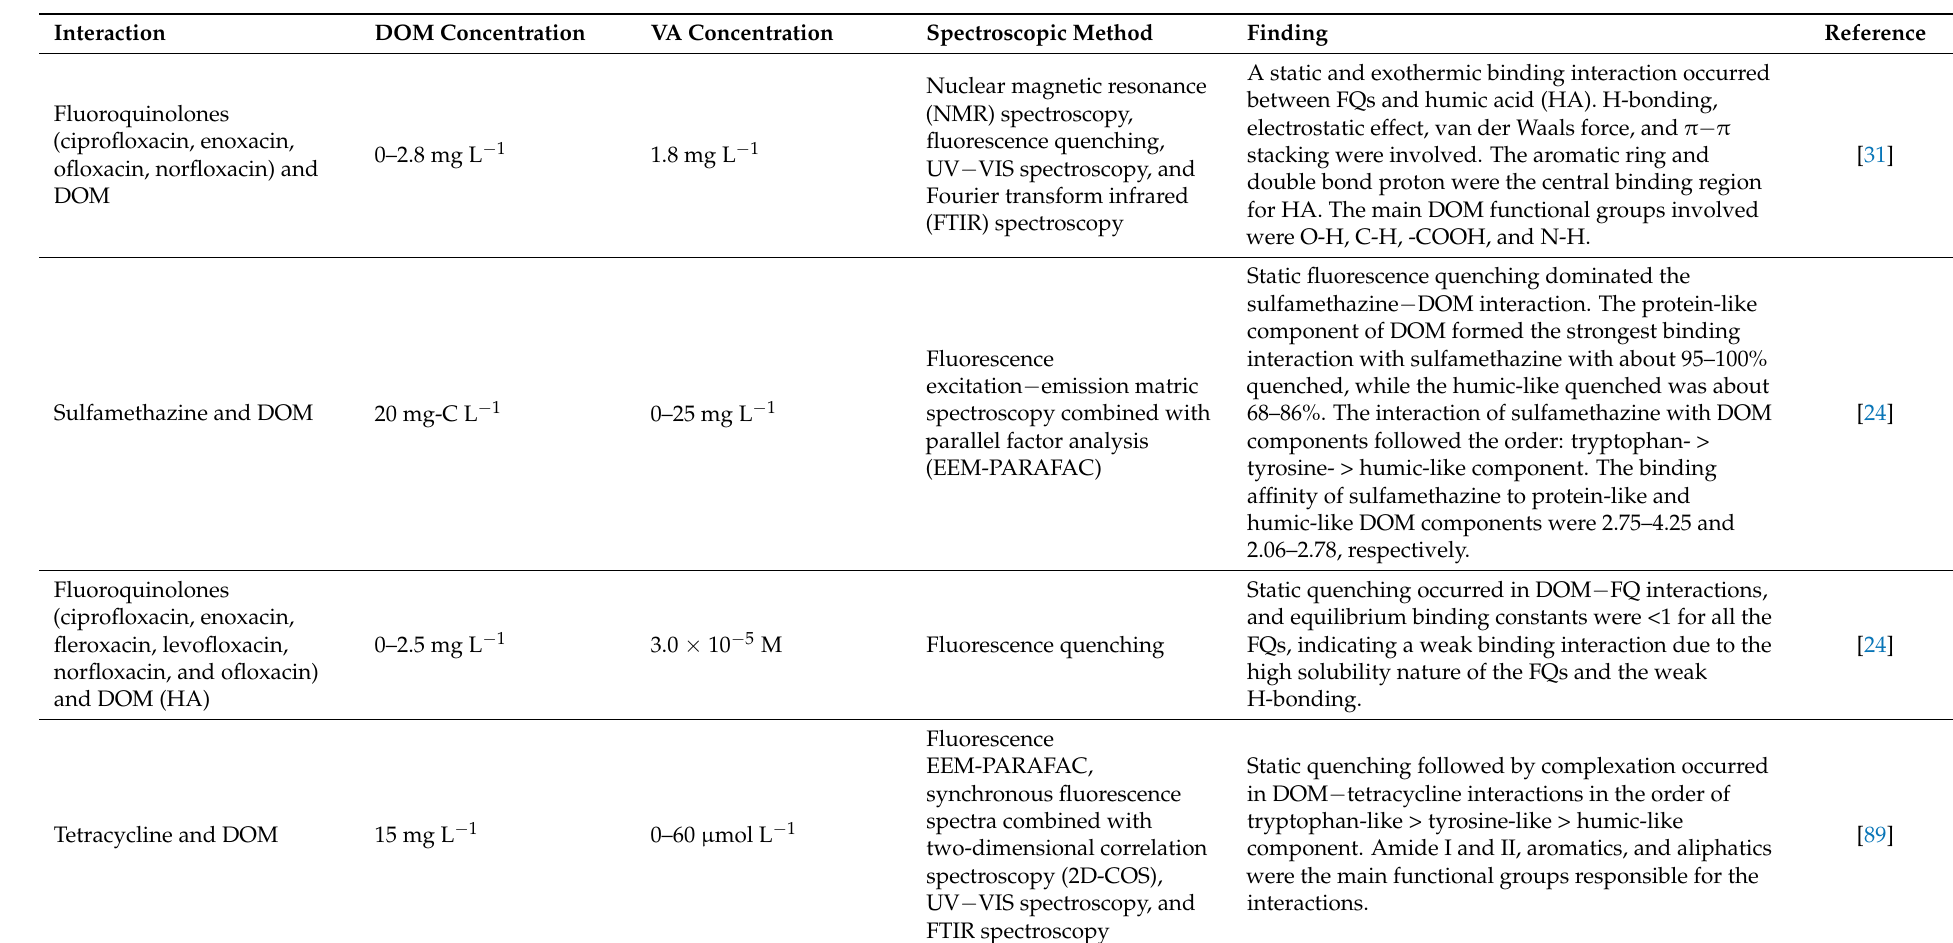
Table 2. A summary of the findings on DOM − VA interactions using various spectroscopic